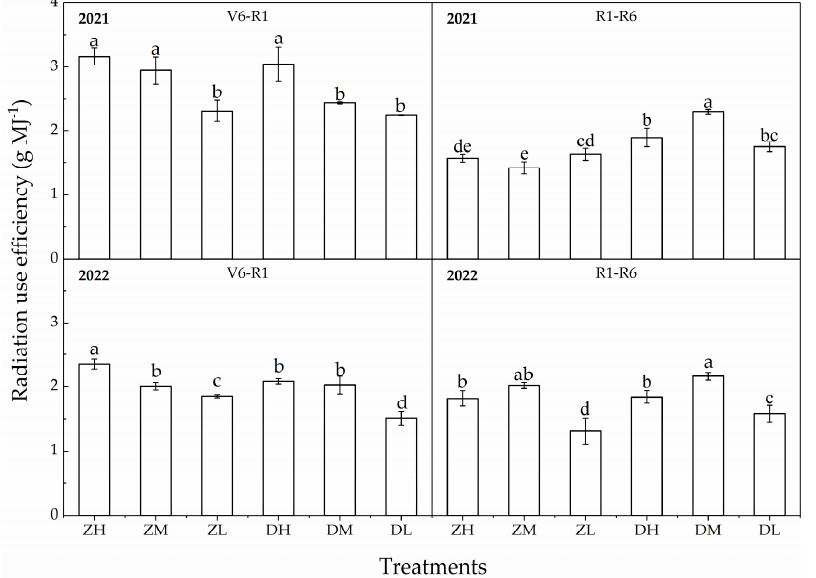
Figure 6. Effects of planting densities and genotypes on dry-matter accumulation at V6 (the sixth − leaf stage), V12 (the twelfth − leaf stage), R1 (silking stage), R2 (filling stage), and R6 (mature stage) in 2021 and 2022 summer maize growing seasons. Z represents Zhengdan 958, D represents Denghai 605; H represents high density, M represents middle density, and L represents low density. Vertical bars represent standard errors. Bars labeled at the top of the column with different letters are significantly ( p < 0.05) different among treatments using LSD post hoc test.